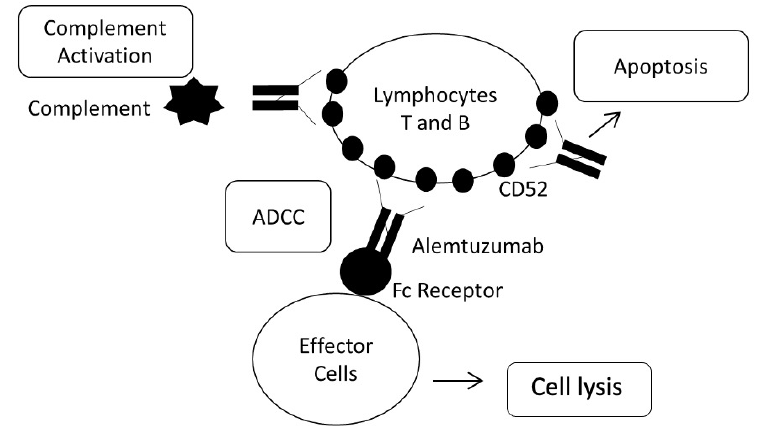
Figure 5. Mechanism of action of alemtuzumab.